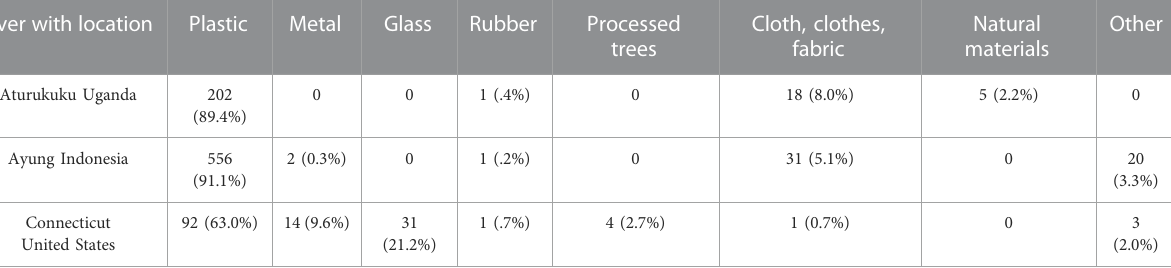
TABLE 2 Collected material by type from three sites in Uganda, Indonesia, and the United States; in parentheses fi nd the percentage of the total amount of accumulated debris at each site. River with